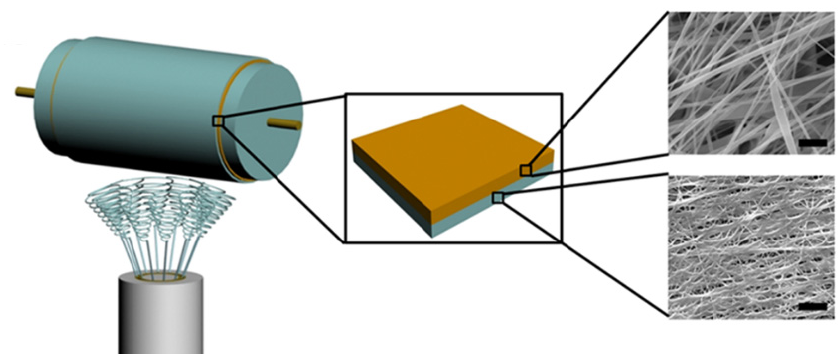
Figure 5. Fabrication of multi-drug-loaded bilayer composite meshes using double-ring slit needleless spinneret. Yellow layer: curcumin-loaded PLLA nanofibre mesh; blue layer: diclofenac sodium-loaded PEO nanofibre mesh. Reprinted with permission from ACS Appl. Mater. Interfaces 2019 , 11 , 28740–28751. Copyright (2019) American Chemical Society.